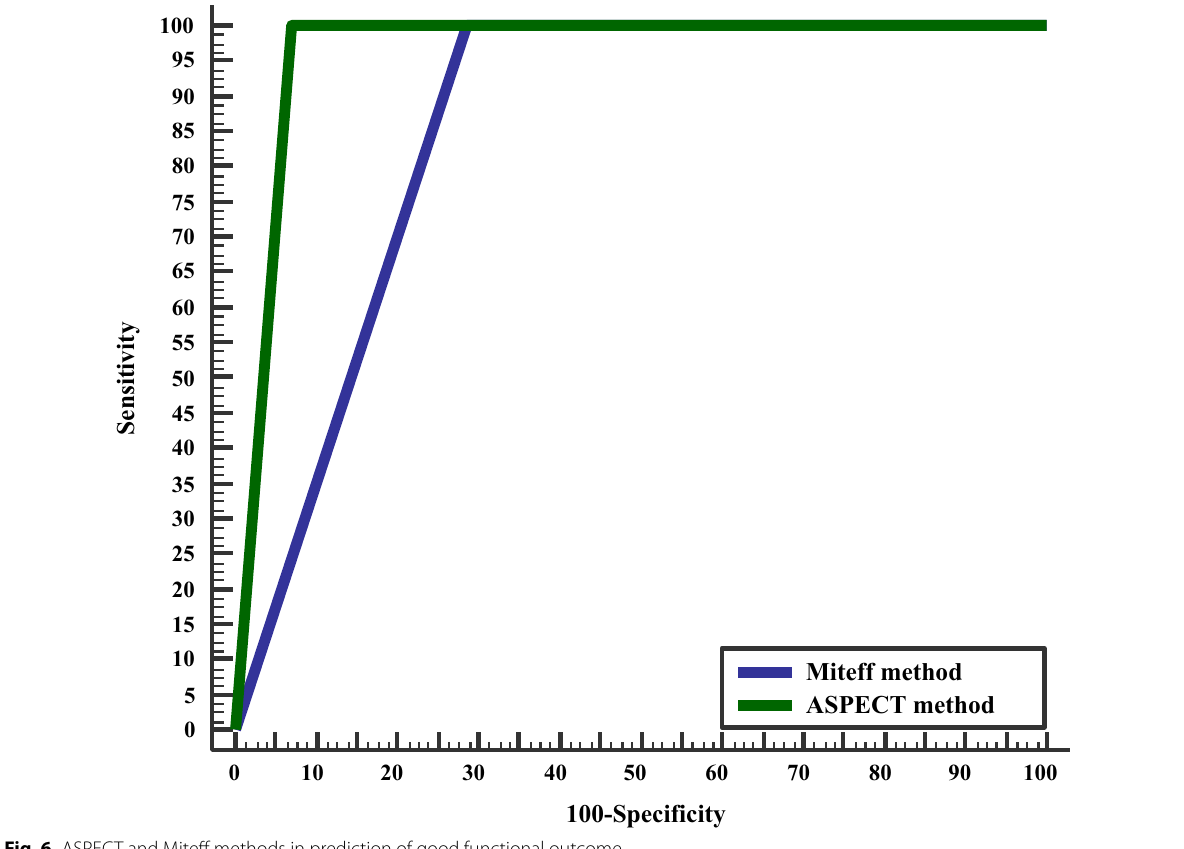
Table 6 Frequency of collateral failure in the current study